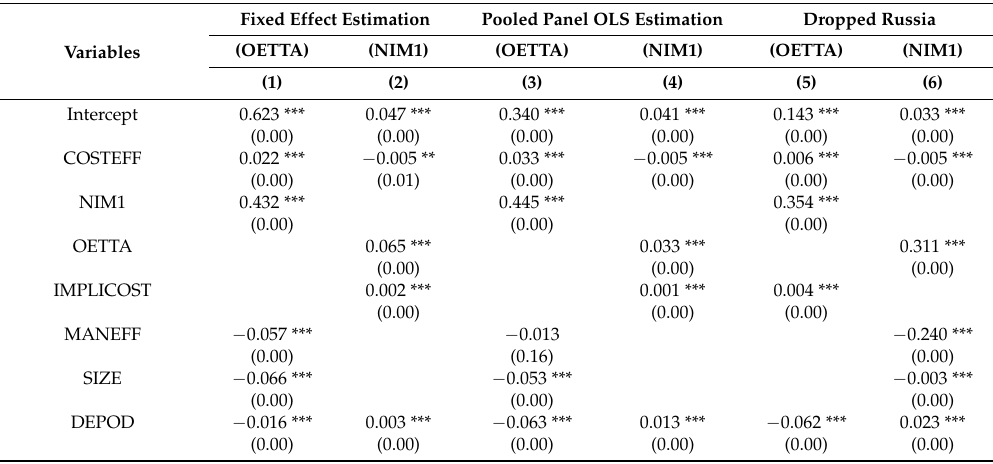
Table 6. Determinants of Equity Capital and Banks’ Intermediation